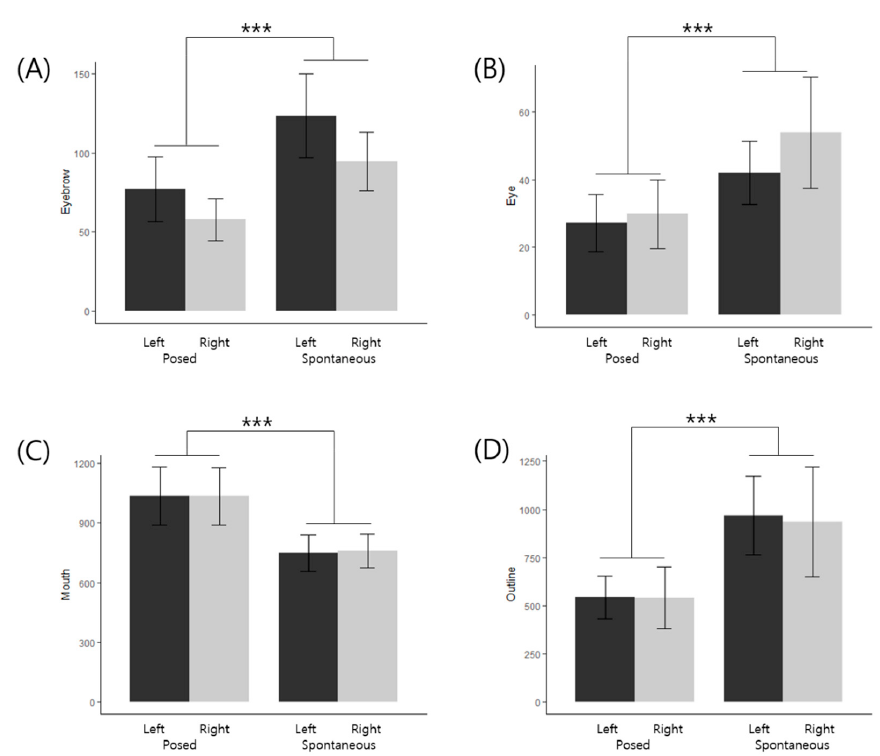
Figure 6. Classification of 3D landmarks in facial features to posed and spontaneous smiles with left and right faces. The difference in mean scores on posed/spontaneous smile intensities and left/right side of ( A ) Eyebrow. ( B ) Eye. ( C ) Mouth. ( D ) Outline. (*** P < 0.001).